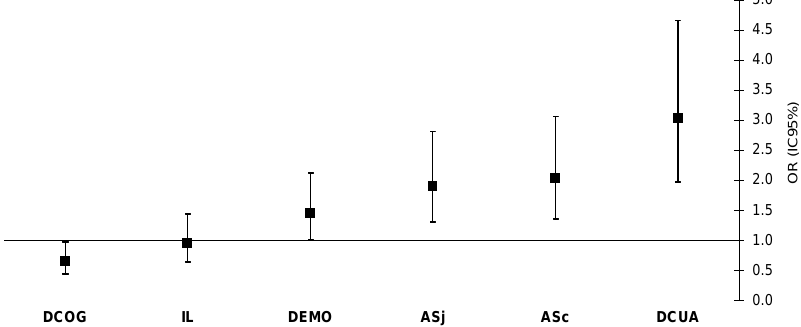
Figure 4. Odds Ratios of psychosocial risk factors and poor SHS. ASc = social support from colleagues, ASj = social support from bosses, IL = job insecurity, DEMO = emotional demand, DCOG = cognitive demand, DCUA = quantitative demand.